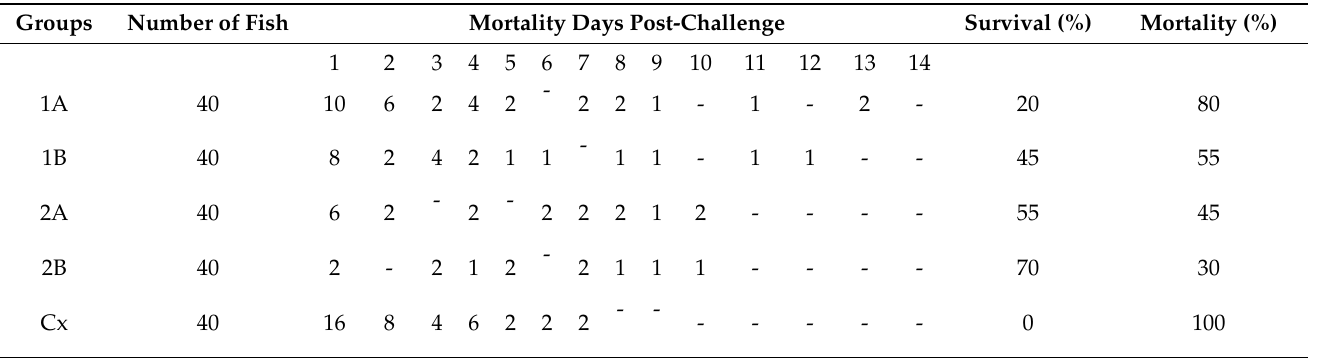
Table 2. The number, percentage survival and percentage mortality in Red hybrid tilapia after challenged with 1 × 10 6 CFU/mL live S. iniae by intraperitoneal injection. Groups Number of Fish Mortality Days Post-Challenge Survival